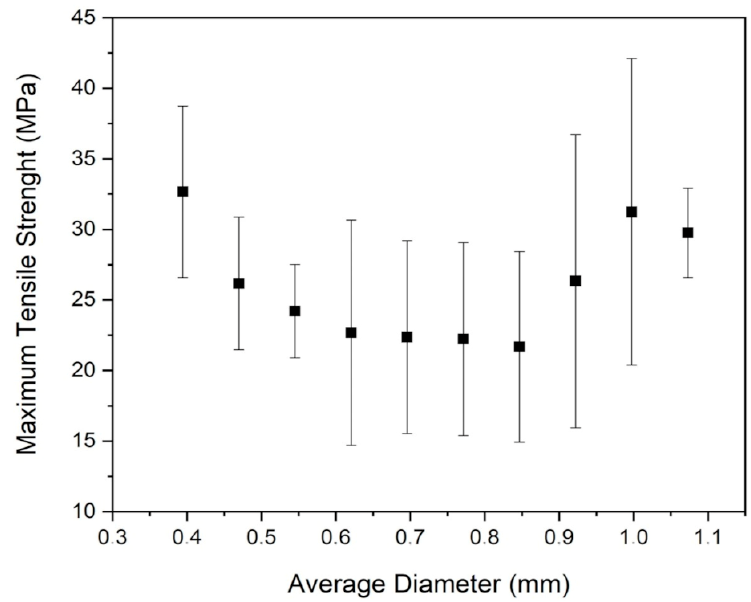
Figure 7. Maximum tensile strength of TVFs as a function of diameter.